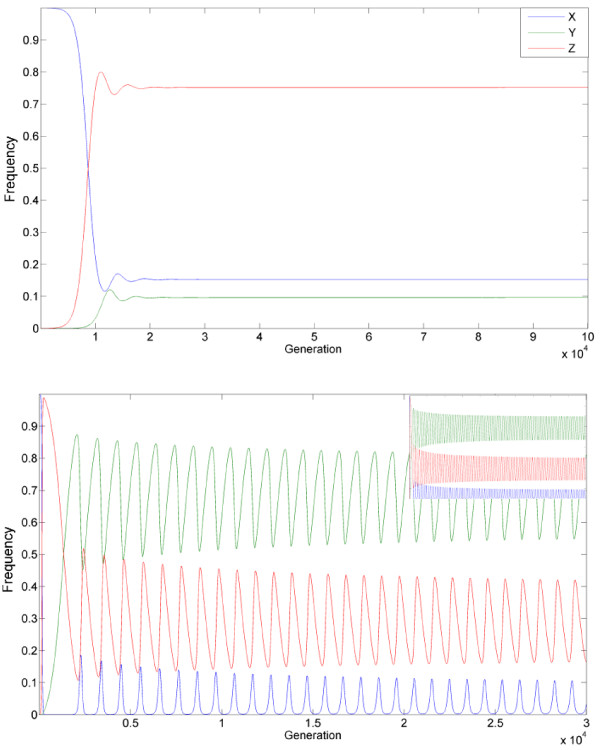
Examples of homing endonuclease persistence at a high frequency. A) Equilibrium with a high frequency obtained using the parameters: s = 0.01, t = 0.001, hm = 0.0123, u = 10-4 and v = 10-6. B) A periodic solution obtained using the parameters: s = 0.027, t = 0.0027, hm = 0.0969, u = 10-4 and v = 10-6 (small top panel: same for 106 generations).